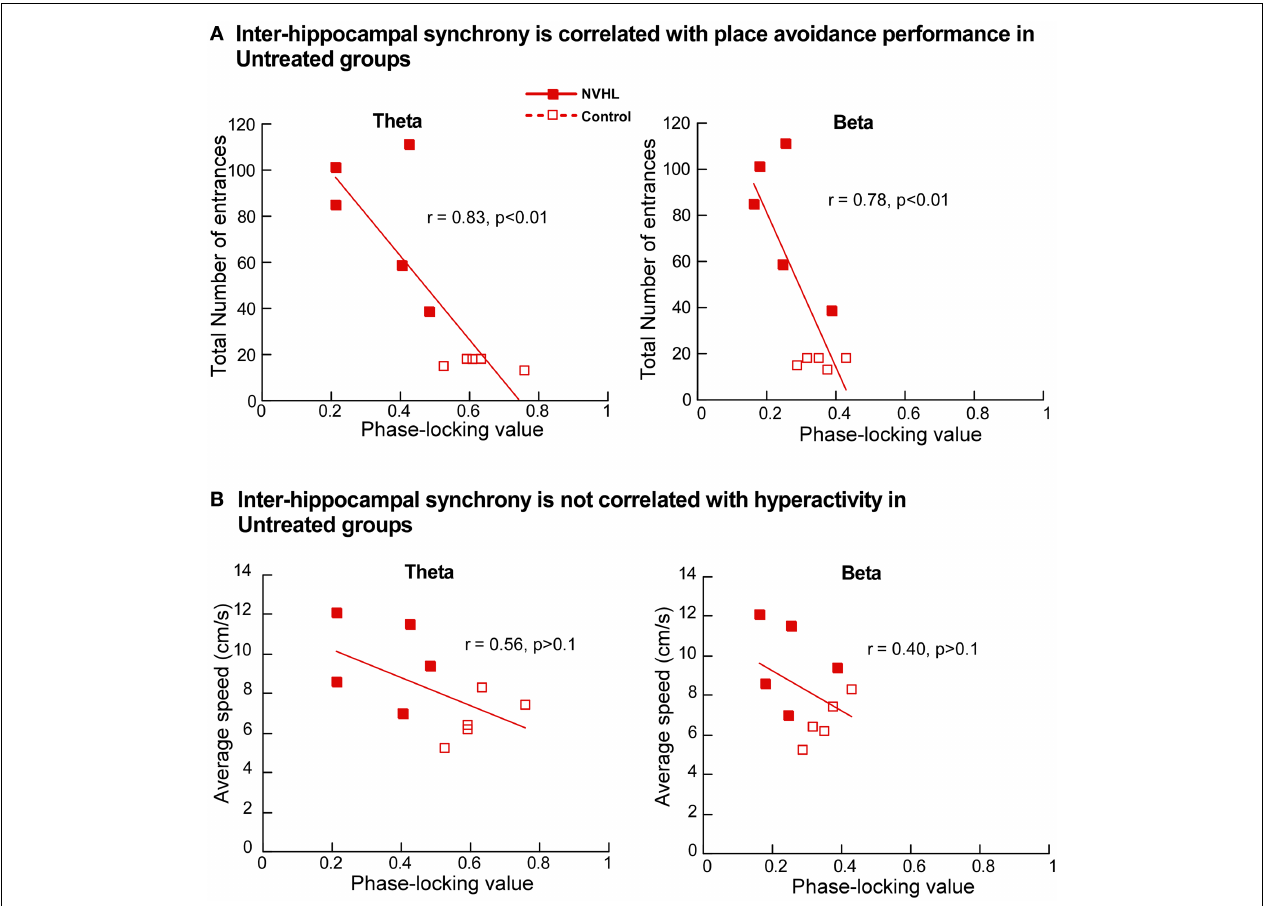
of errors in the two-frame avoidance task. (B) In the untreated NVHL and control rats, theta phase-locking values (left) and beta phase-locking values (right) were not correlated with hyperactivity, measured as running speed during the two-frame avoidance